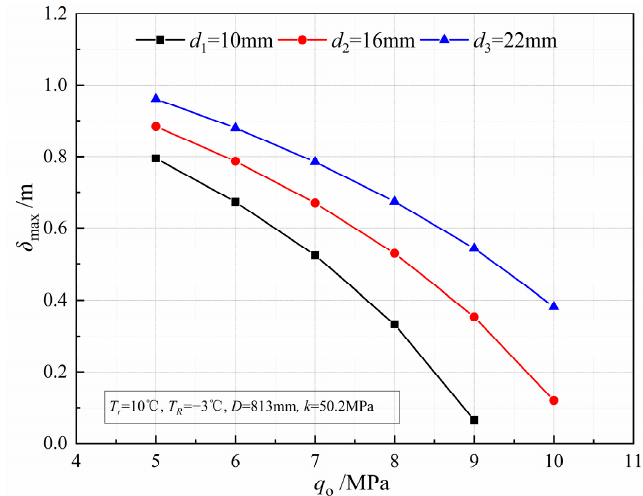
Figure 7. Effect of oil pressure on maximum allowable frost heave deformation.